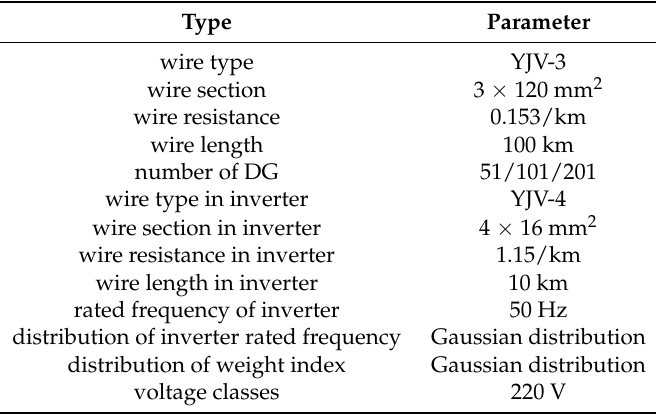
Table 1. Related parameters in Case 1.